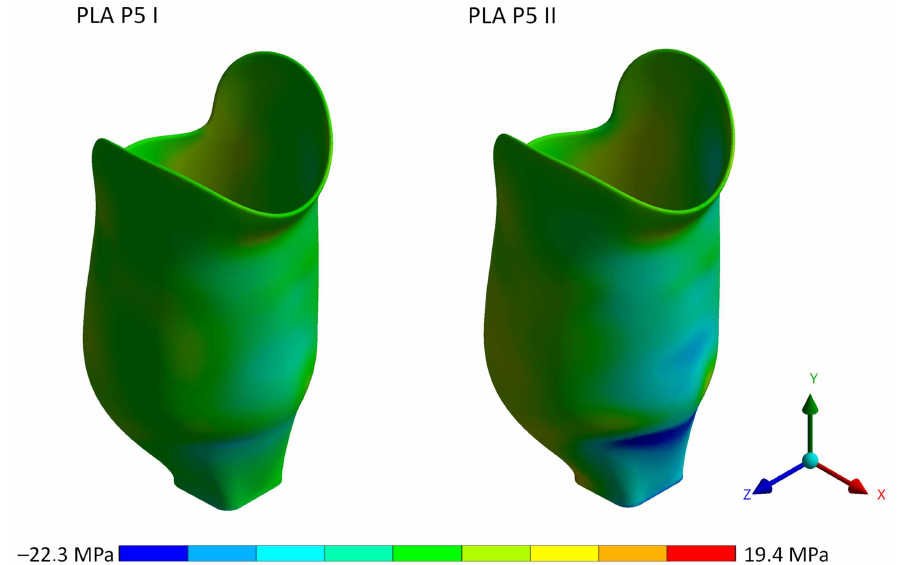
Figure 9. Normal stress distribution in the y-axis for a PLA socket at proof test force. Negative values stand for compressive stress, positive values for tensile stress.